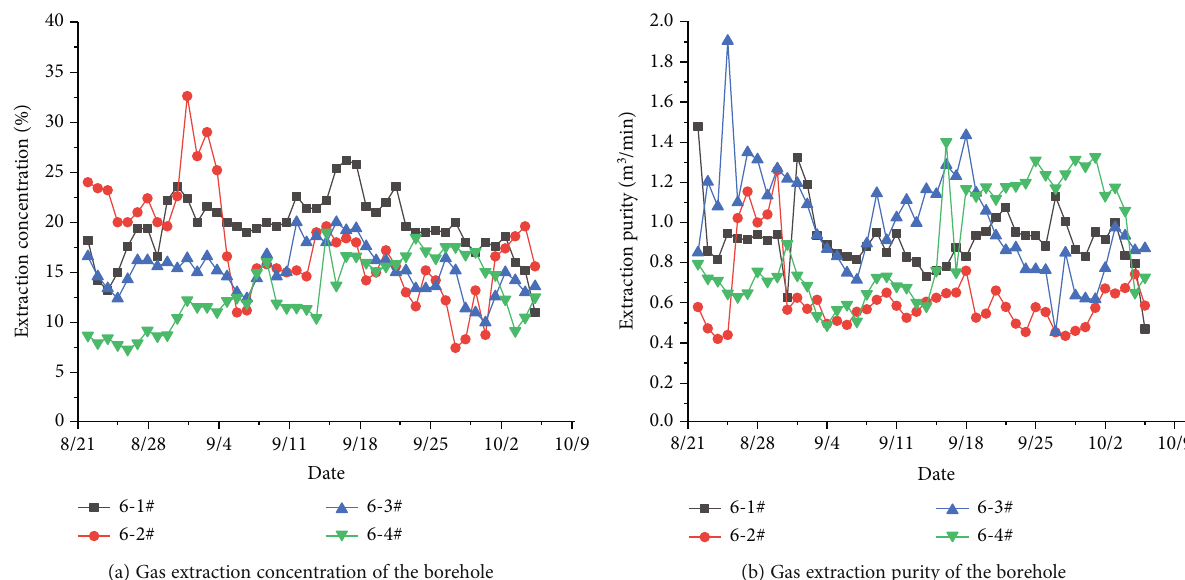
Figure 12: Extraction e ff ect of the high-level directional long borehole.